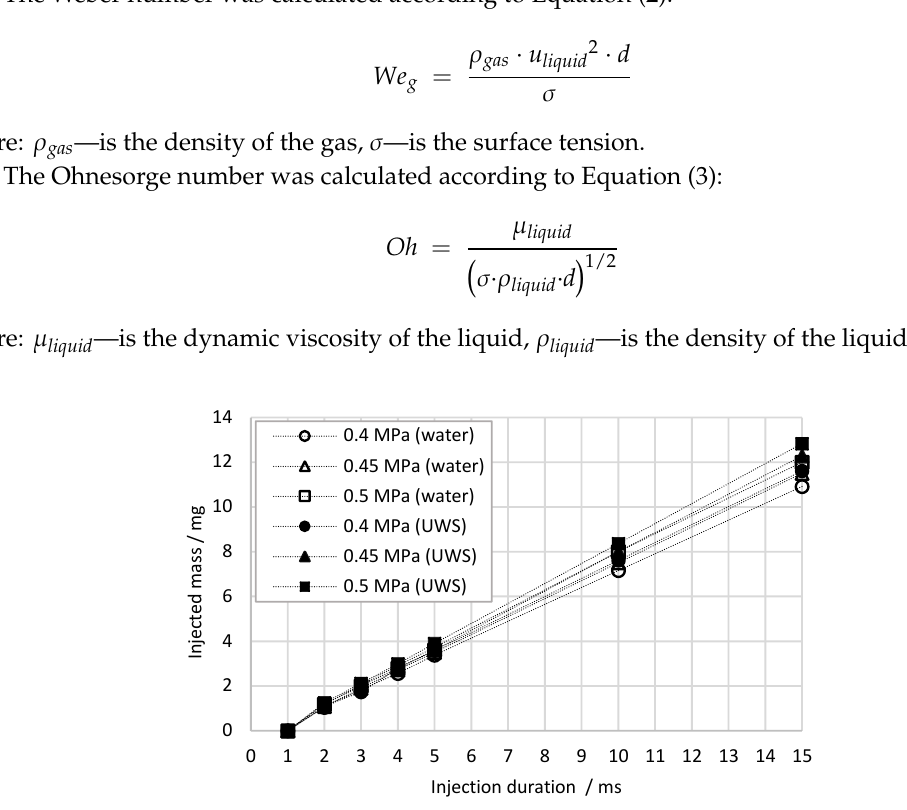
Figure 1. Injected mass during single injection; average values for 3 measurements (each of 5000 injections) for water and UWS for di ff erent injector opening times for all considered injection pressures (gauge).